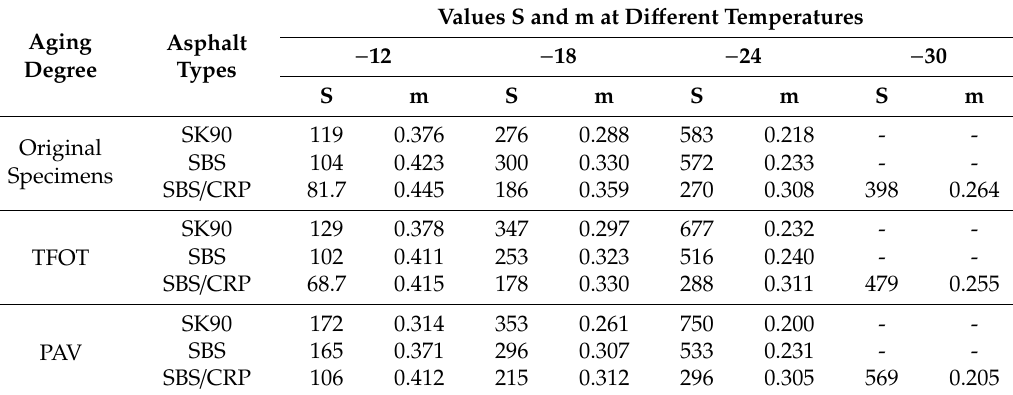
Table 5. Bending beam rheometer (BBR) test